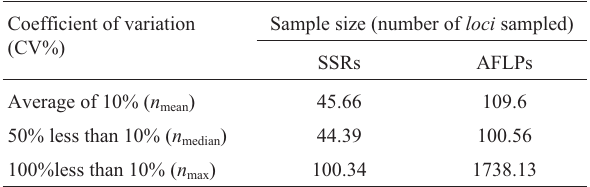
Table 4 - Sample size (number of loci sampled) required for genetic dis- tancestohavethespecifiedcoefficientofvariation(CV%)incariocacom- mon